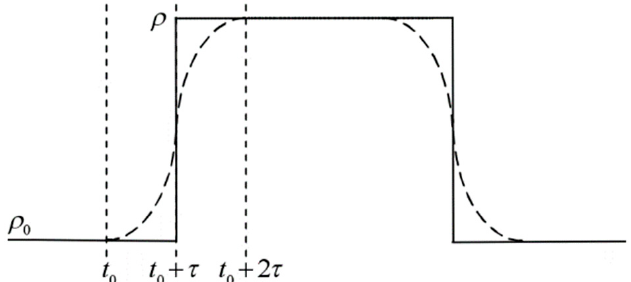
Figure 6. Corrected Curvature with Sinusoidal.